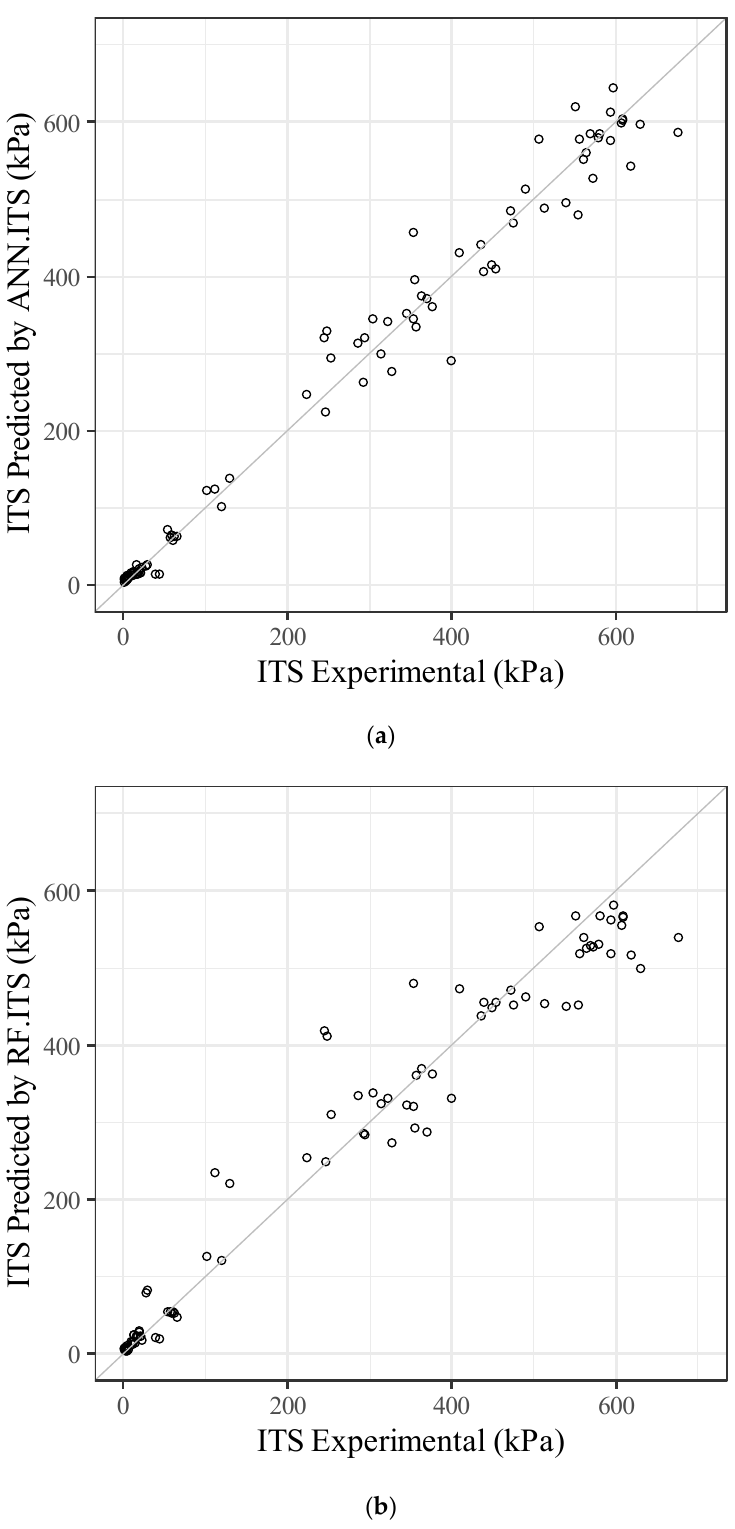
Figure 7. The relationship between ITS experimental versus predicted values of soil–binder–water mixtures reinforced with fibers according to: ( a ) the ANN.ITS model; ( b ) the RF.ITS model. Concerning to model’s interpretability, Figure 8 compares the relative importance of each model attribute. As for the UCS study, with the ANN.ITS model taken as a reference, the dosage of the binder ( D Kg/m3 ) was identified as the most relevant variable in ITS pre- diction with a relative influence close to 16%. A higher influence of the fibers is also ob- served, which was considered by the ANN.ITS model through E fiber ( 7.2%), F Kg/m3 (7.1%) and T fibre (7.0%) , which ranks in the five most relevant variables. This higher influence of the fibers on the ITS prediction, when compared to the UCS study, is in agreement with some empirical studies [10,14,16]. In fact, when the composite material is subject to indi- rect tensile through a splitting failure mechanism, there is an effective mobilization of the tensile strength of the fibers that cross the vertical failure plane imposed by the ITS test, and consequently, the tensile strength is directly related to the fibers’ characteristics. Ac- cording to RF.ITS, once again, an influence above 40% is observed for ω 0/ a w , which demon- strates the coherence of the algorithm.